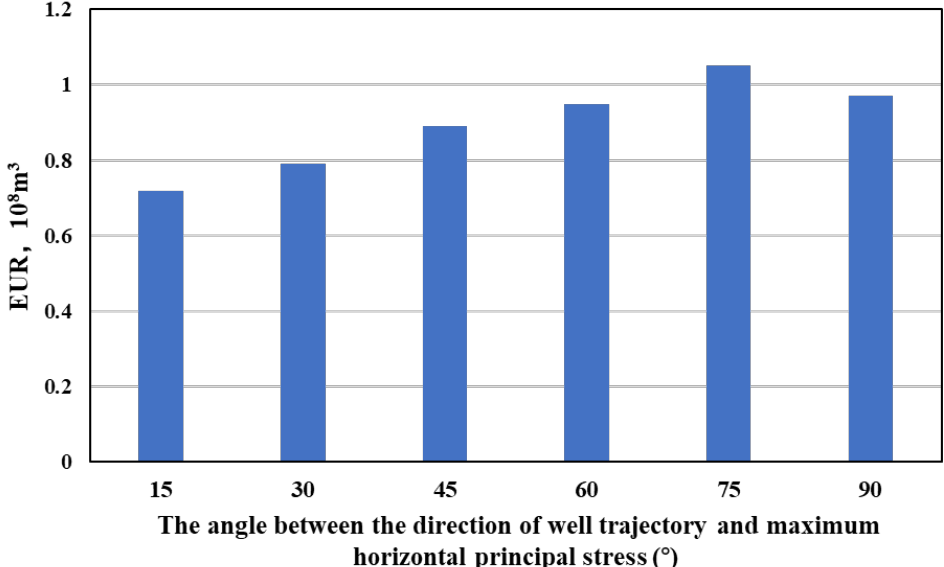
Figure 6. The EUR of different angle.